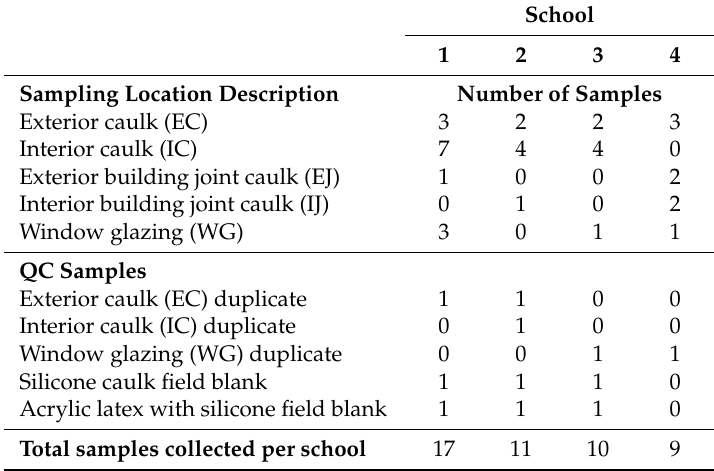
Table 4. Number and Types of Caulk and Glazing Material Samples Collected from Each